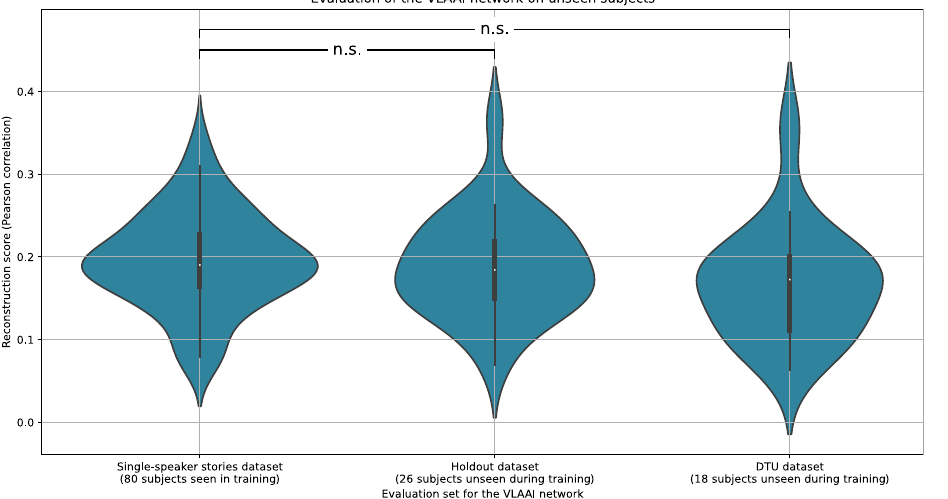
Figure 4. Generalization between the single-speaker stories dataset, the holdout dataset and the single-speaker trials of the publicly available DTU dataset. Each point in the violin plot is the reconstruction score for a subject, averaged across stimuli. No significant difference in reconstruction score was found between the single-speaker stories and the holdout dataset ( p = 0.23) and between the single-speaker stories and the DTU dataset ( p = 0.08). (n.s.: p ≤ 0.05, *: 0.01 ≤ p < 0.05, **: 0.001 ≤ p < 0.01, ***: p <